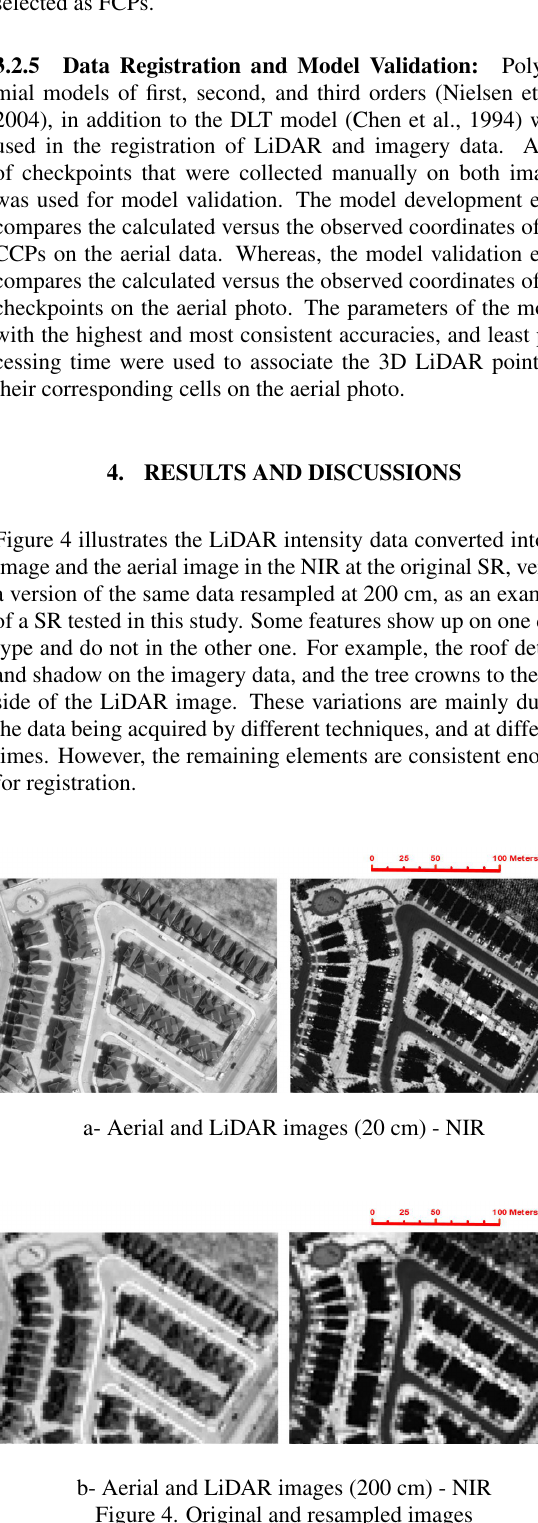
Figure 4. Original and resampled images